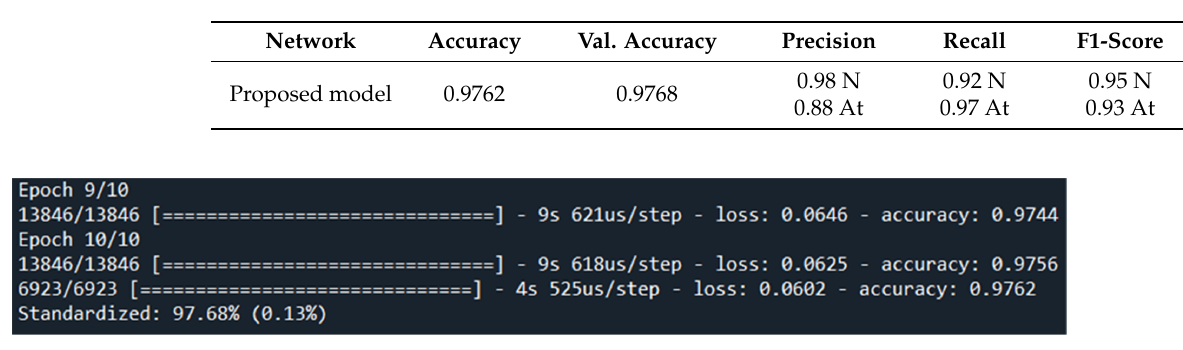
Figure 8. Screen shot for training and validation accuracy results from terminal output.